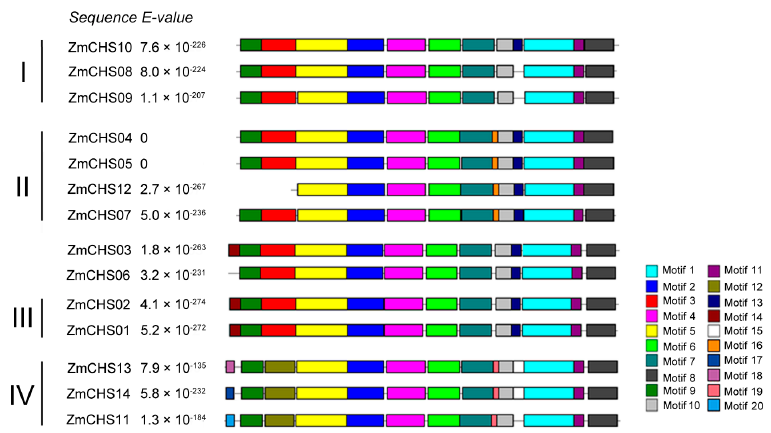
Figure 2. Distribution of 20 conserved motifs in the putative CHS proteins of maize. Motifs in the putative ZmCHS proteins were obtained using the Multiple Em for Motif Elicitation (MEME) web server. The length of each box does not represent the actual size of each motif. Table 2. Detailed information of the 20 motifs in the putative maize chalcone synthase (CHS) proteins.